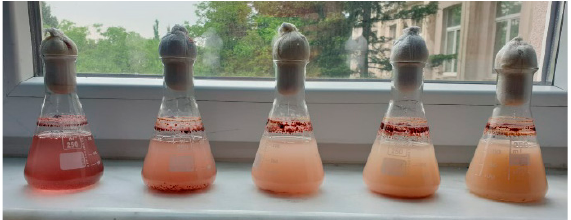
Figure 1. Cultivation of Porphyridium purpureum microalgae strain on dairy wastewaters—samples of increasing concentrations of lactose (0, 2.5, 5, 7.5, 10